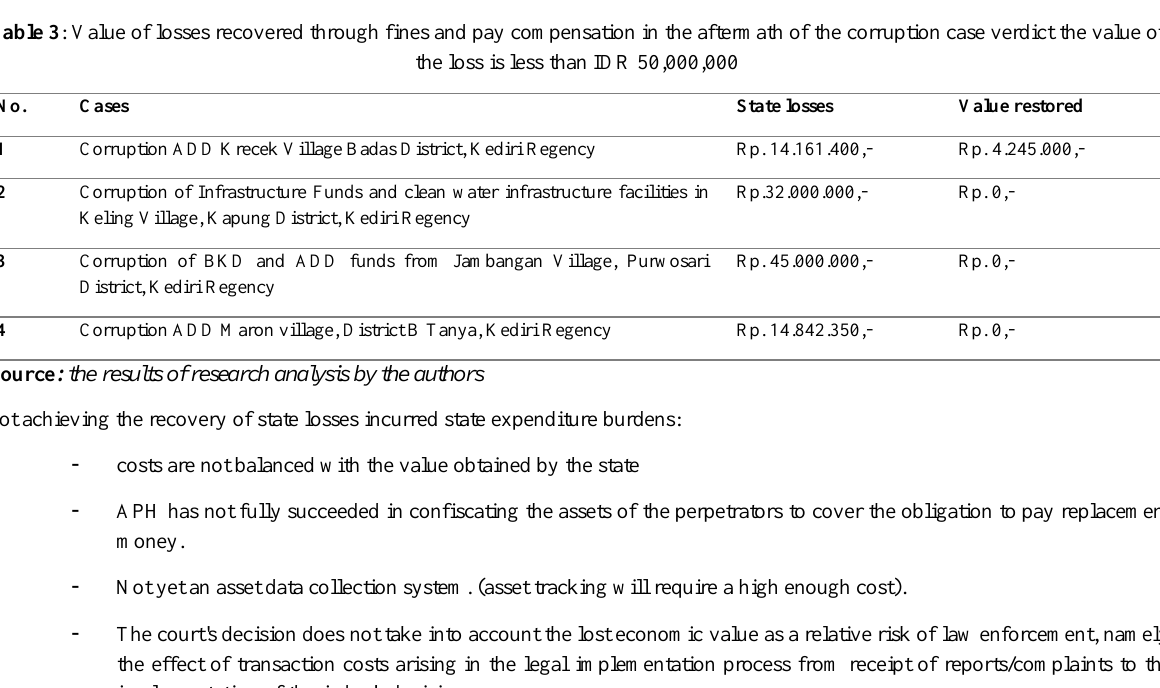
Table 3 : Value of losses recovered through fines and pay compensation in the aftermath of the corruption case verdict the value of